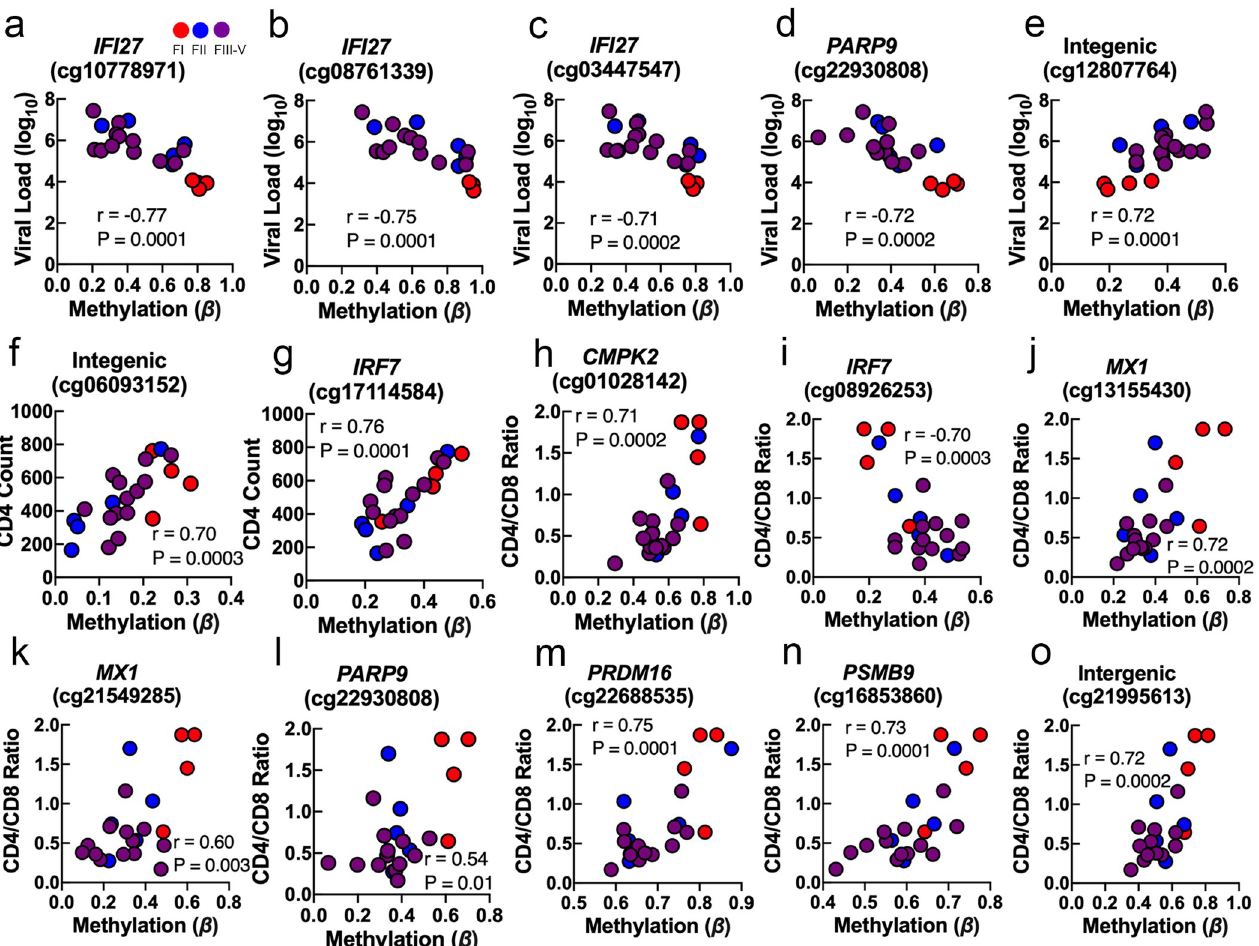
Fig 2. Associations of monocyte cell type-specific DNA methylation with viral load, CD4 count, and CD4/CD8 ratio. Scatter plots showing the correlation between (a-e) plasma viral load, (f-g) pre-ART CD4 count, and (h-o) pre-ART CD4/CD8 ratio and DNA methylation levels at single CpGs sites related to specific annotated protein-coding genes displayed in bold italic above CpG ID (cg#) in monocyte cells during AHI at entry. P-values were calculated with the Spearman correlation test.